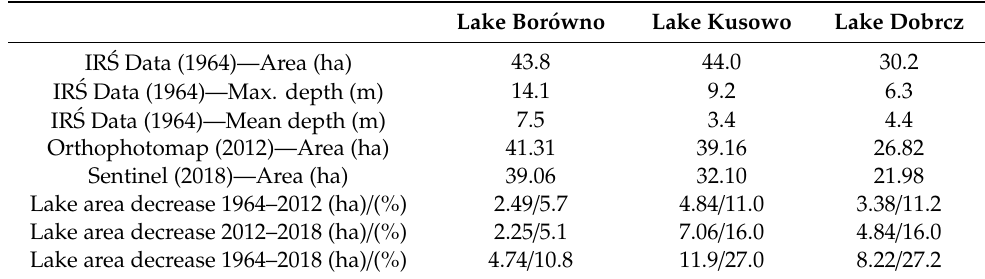
Table 4. Comparison of the surface area and the depth of Lakes Bor ó wno, Kusowo, and Dobrcz on the basis of source materials from di ff erent years (based on: Sentinel data [64], orthophotomap [70], Inland Fisheries Institute (IR´S) measurements [71], and own measurements). Lake Bor ó wno Lake Kusowo Lake Dobrcz IR´S Data (1964)—Area (ha)